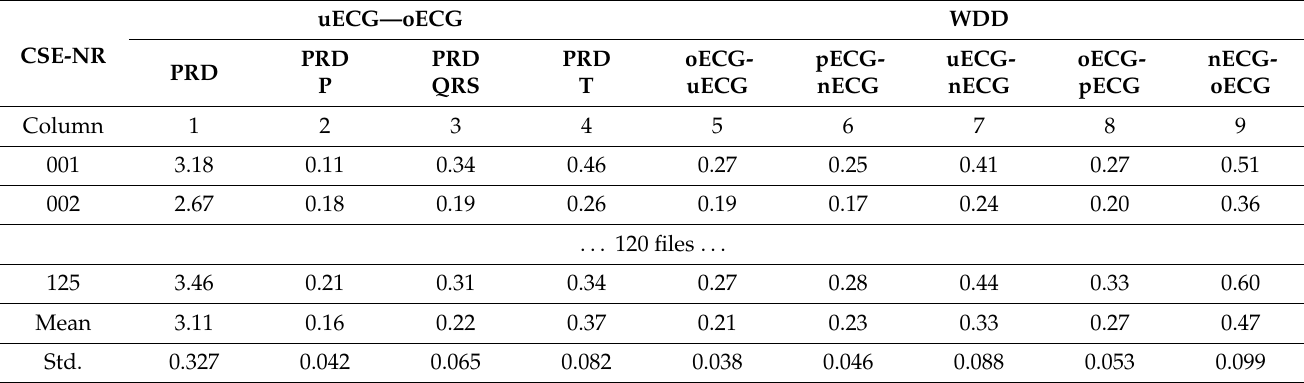
Table 8. Signal error (PRD) and diagnostic result error (WDD) measures (CSE database, files 67 and 70 are excluded); all values in [%].